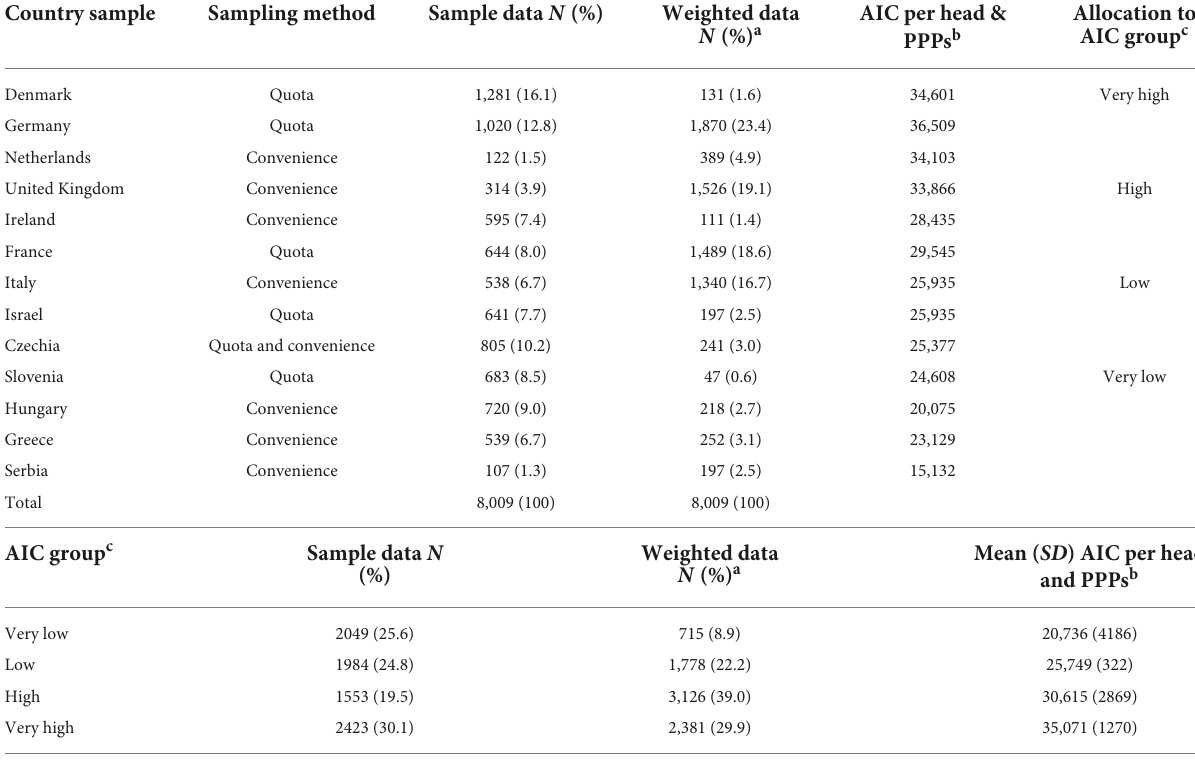
a Weightedaccordingtoeachcountry’s2020population:https://data.oecd.org/pop/population.htm. b AICisActualIndividualConsumptionperheadatcurrentprices($)andpurchasing power parity (PPP), 2019: https://www.oecd-ilibrary.org/economics/actual-individual-consumption-price-indices_26ff7815-en (26). c Quartile segmentation based on country Actual